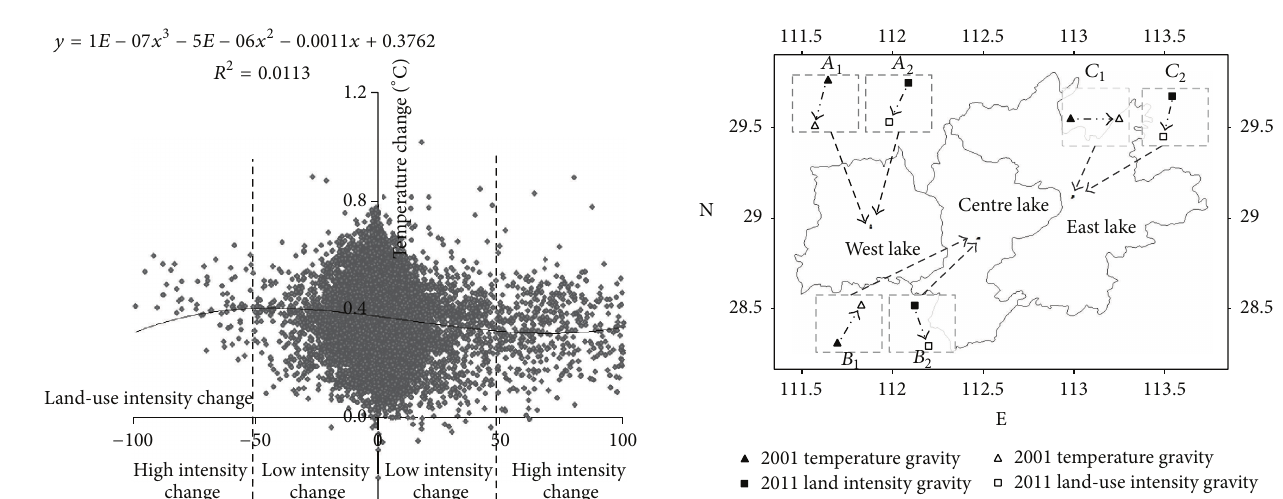
Figure8:Changeinthedirectionofthecentreofgravityoftheland- use intensity and temperature from 2001 to